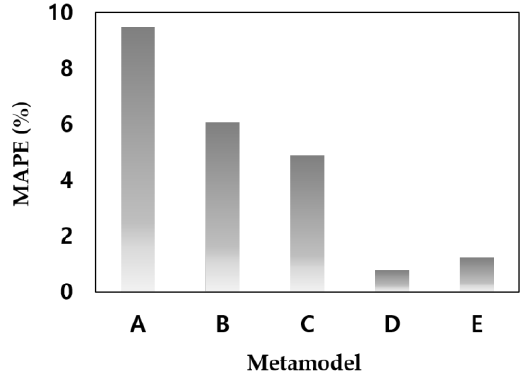
Figure 5. MAPE of each metamodel for the new test dataset.